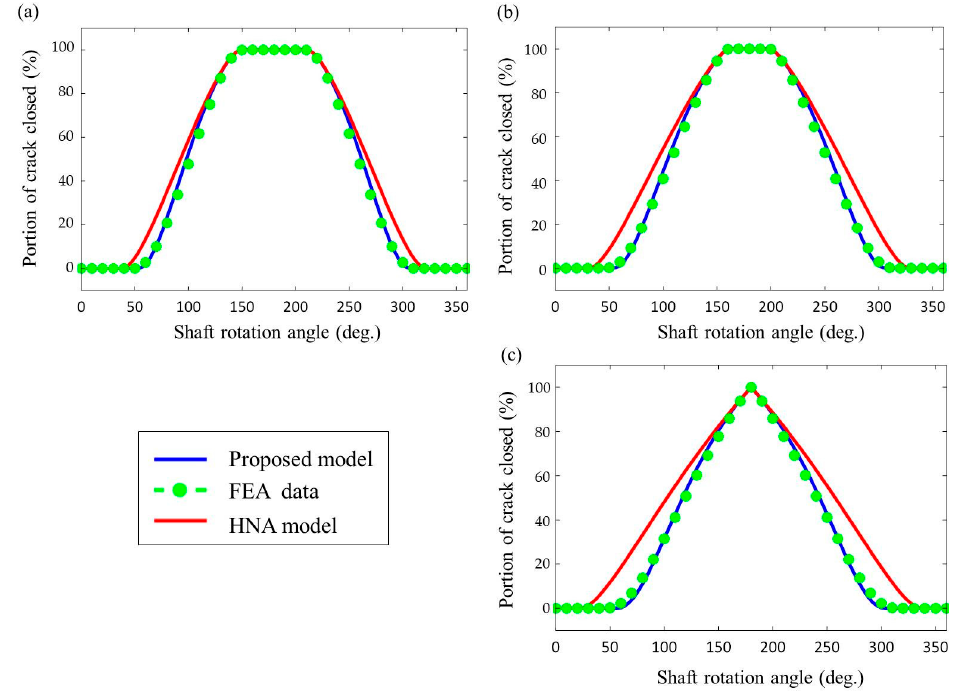
Figure 9. Percentage of the crack closure as the shaft rotates. Chosen crack depths of ( a ) µ = 0.5, ( b ) µ = 0.7 and ( c ) µ = 1. R = 6.35 mm.